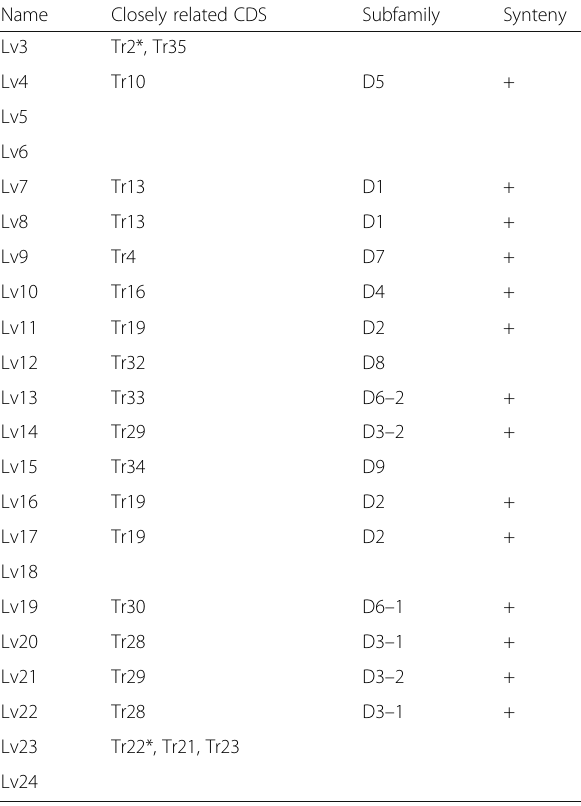
(A) Relationship between X. tropicalis and X. laevis transposases and (B) relationship between X. laevis and X. tropicalis transposases. Asterisks in the “ closely related CDS ” column indicate CDSs used in the analysis of differences in nucleotides and amino acids between X. laevis and X. tropicalis (Table